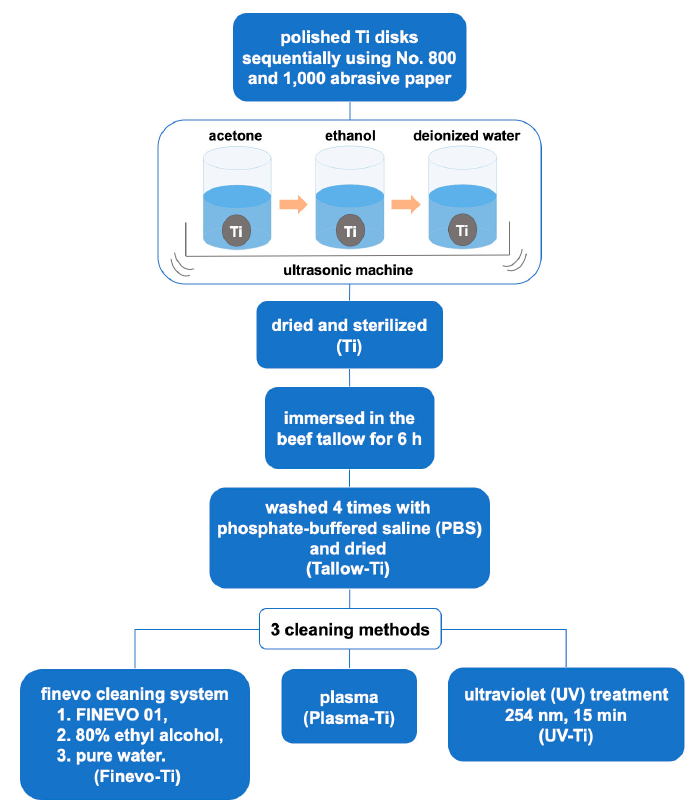
Figure 1. Illustration of contamination construction and three cleaning methods.